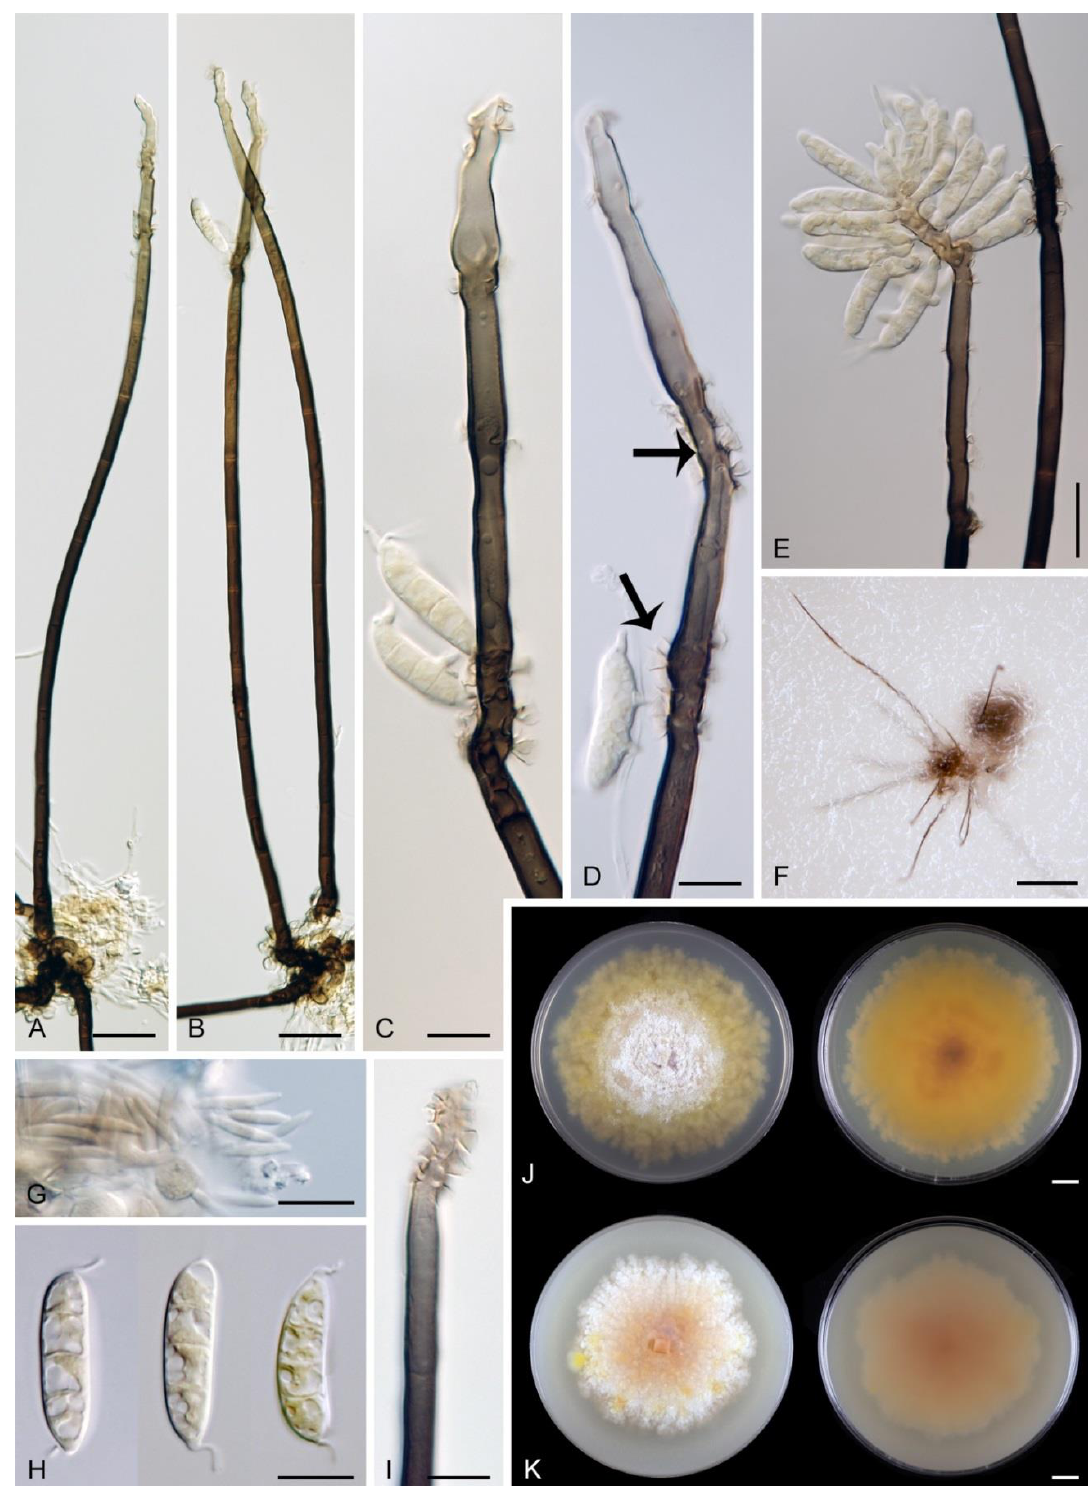
Figure 9. Multiguttulispora dimorpha . (CBS 140002). ( A , B ) conidiophores ( C – E , I ) upper fertile part of the conidiophores with lateral phialidic openings with collarettes (arrows indicate collarettes) ( F ) subsurface conidiophores arising in a group ( G ) microconidia ( H ) conidia ( J , K ) colonies (front and reverse). Images: ( A – E , G – I ) on SNA with pine needles after 8 weeks; ( F ) on PCA after 12 weeks; ( J ) on MLA after 8 weeks; ( K ) on OA after 8 weeks. Scale bars: ( A , B ) 25 μm; ( C , D , G – H ) 10 μm; ( F ) 250 μm; ( E ) 20 μm; ( J , K ) 1 cm. Basionym: Codinaea dimorpha Toyaz. & Udagawa, Mycotaxon 13: 451. 1981. Synonym: Multiguttulispora sympodialis C.G. Lin & J.K. Liu, Mycosphere 10: 681. 2019.